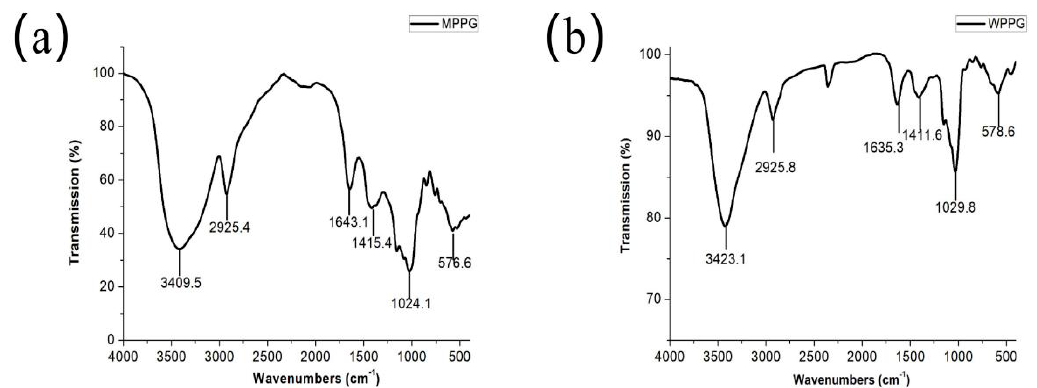
Figure 5. IR spectrum of MPPG ( a ) and hot water extraction used to prepare P. ginseng polysaccharides (WPPG) ( b ).